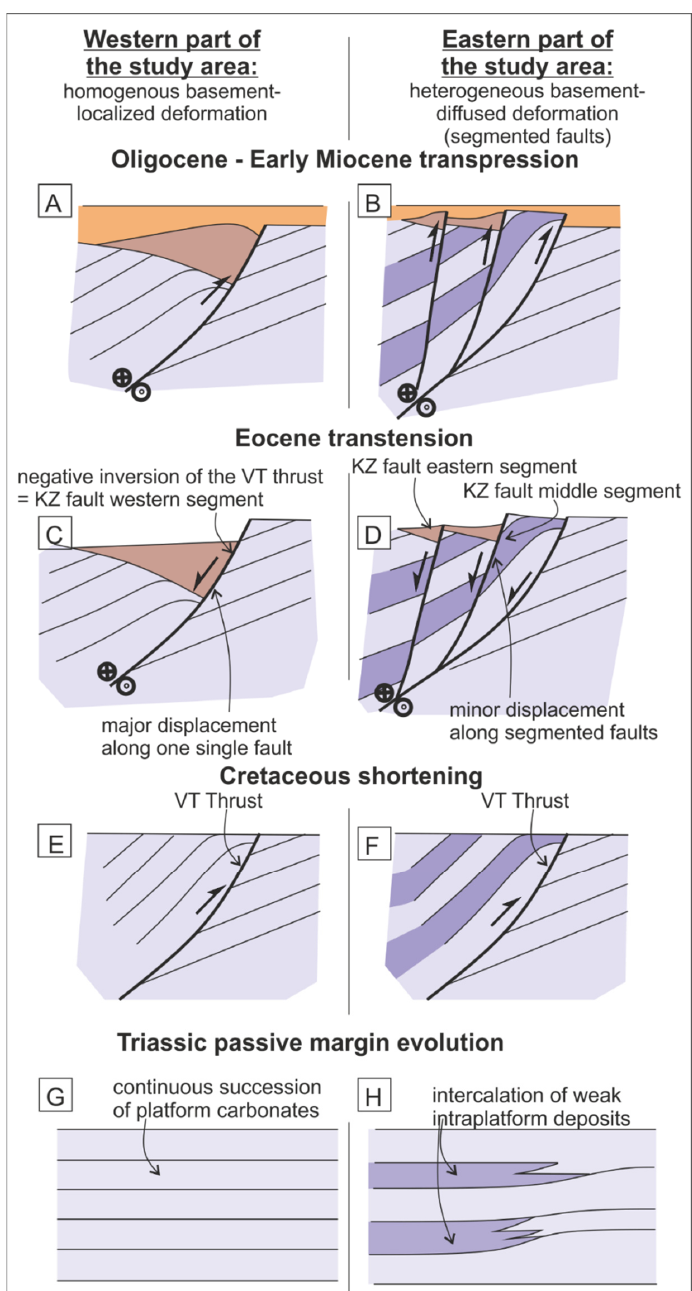
Figure 12. Schematic idealized cross-sections showing the structural evolution of the west- ern ( A , C , E , G ) and eastern ( B , D , F , H ) part of the study area. The Eocene transtensional ( C , D ), and Oligocene–Early Miocene transpressional ( A , B ) deformations reactivated the Cretaceous VT Thrust ( E , F ). The mode of fault reactivation was controlled by the rheology of the Triassic base- ment ( G , H ). Diffuse fault zone developed in the eastern part of the study area, where incompetent basin formations occur in the Triassic basement ( B , D , F , H ). The deformation was localized to a nar- row zone in the west, where the Triassic basement is represented by homogeneous shallow marine carbonates ( A , C , E , G